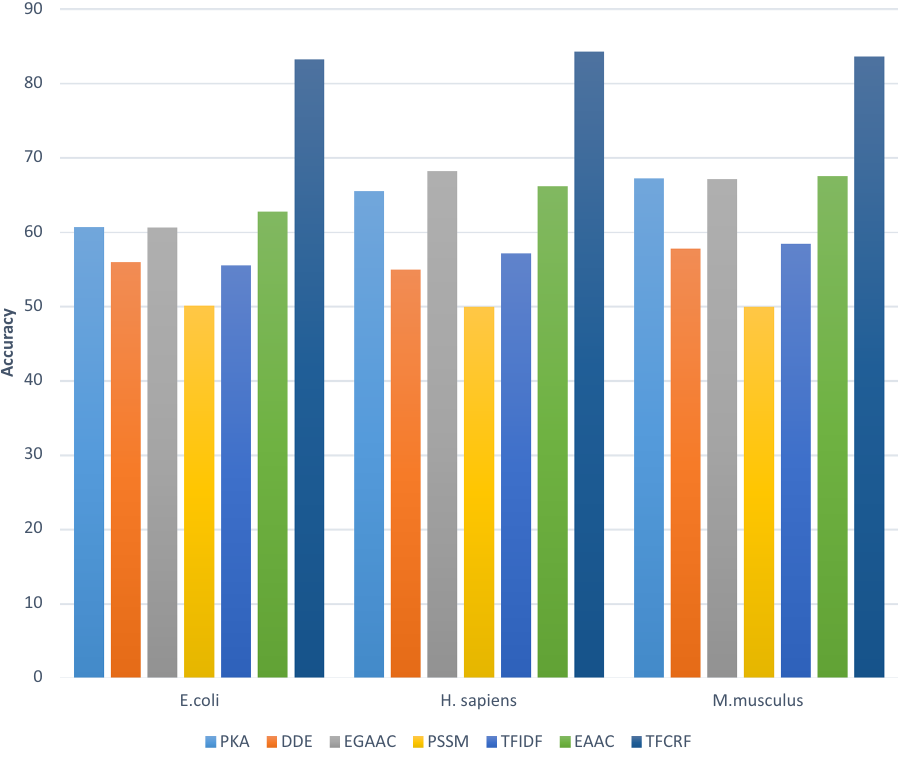
Figure 4. Classifiers’ performance comparison, based on singular